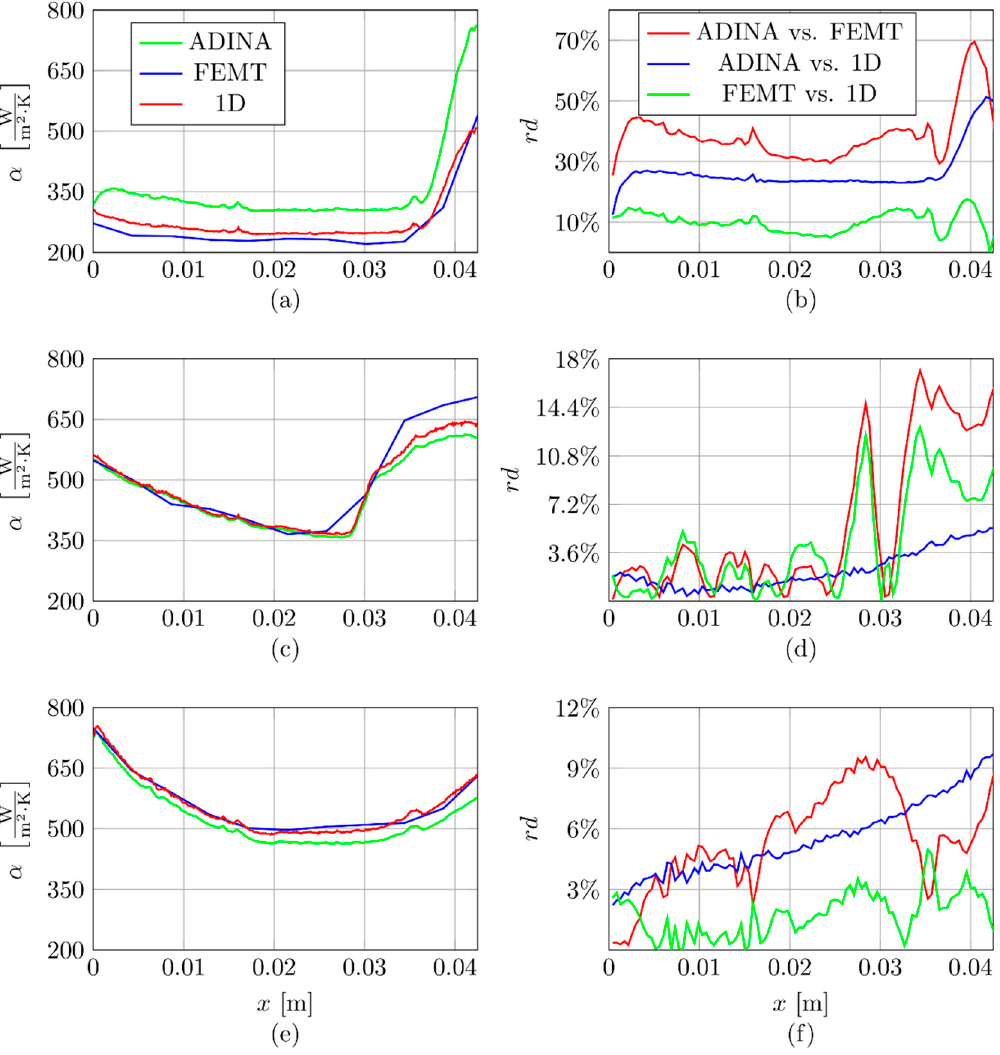
Figure 7. The comparison of the distributions of the heat transfer coefficient versus coordinate x along the length of the minichannel obtained from three calculation methods (FEM using Trefftz functions, ADINA software and the 1D method) ( a , c , e ) and relative differences ( rd ) between the results ( b , d , f ). The data collected for: ( a , b ) Q m = 5 [ kg/h ] , ( c , d ) Q m = 30 [ kg/h ] , ( e , f ) Q m = 55 [ kg/h ] . The data corresponding to ONB points are indicated by black arrows in Figure 4.